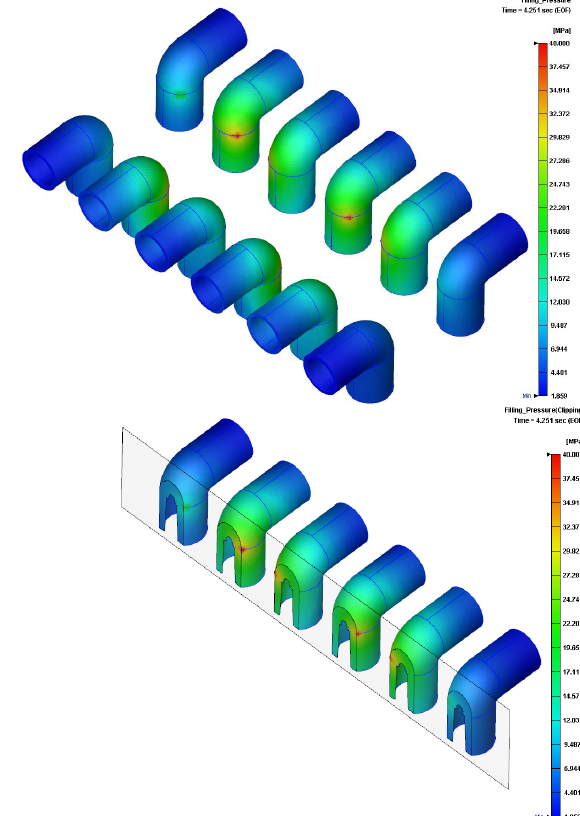
Figure 7. Temperature and pressure distributions of molded parts: ( a ) temperatures of the runners and parts at the end of filling stage; ( b ) temperature of parts at the end of filling stage ; ( c ) clipping view of the temperature distribution of parts at the end of filling stage; ( d ) temperature of parts in the packing stage; ( e ) shear rate distribution during filling stage; ( f ) clipping view of the maximum shear rate during filling stage; ( g ) filling pressure distribution of molded parts; ( h ) clipping view of the filling pressure distribution of molded parts.